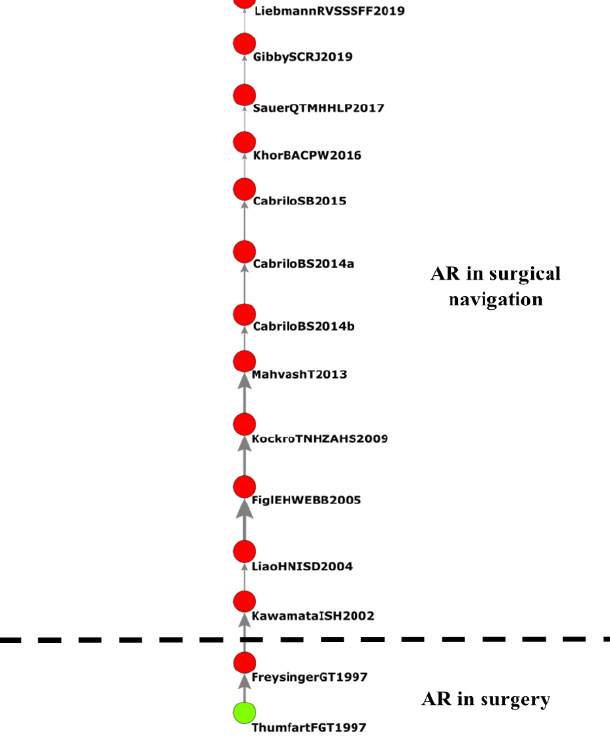
Figure 6. Application of AR technology in surgical navigation.